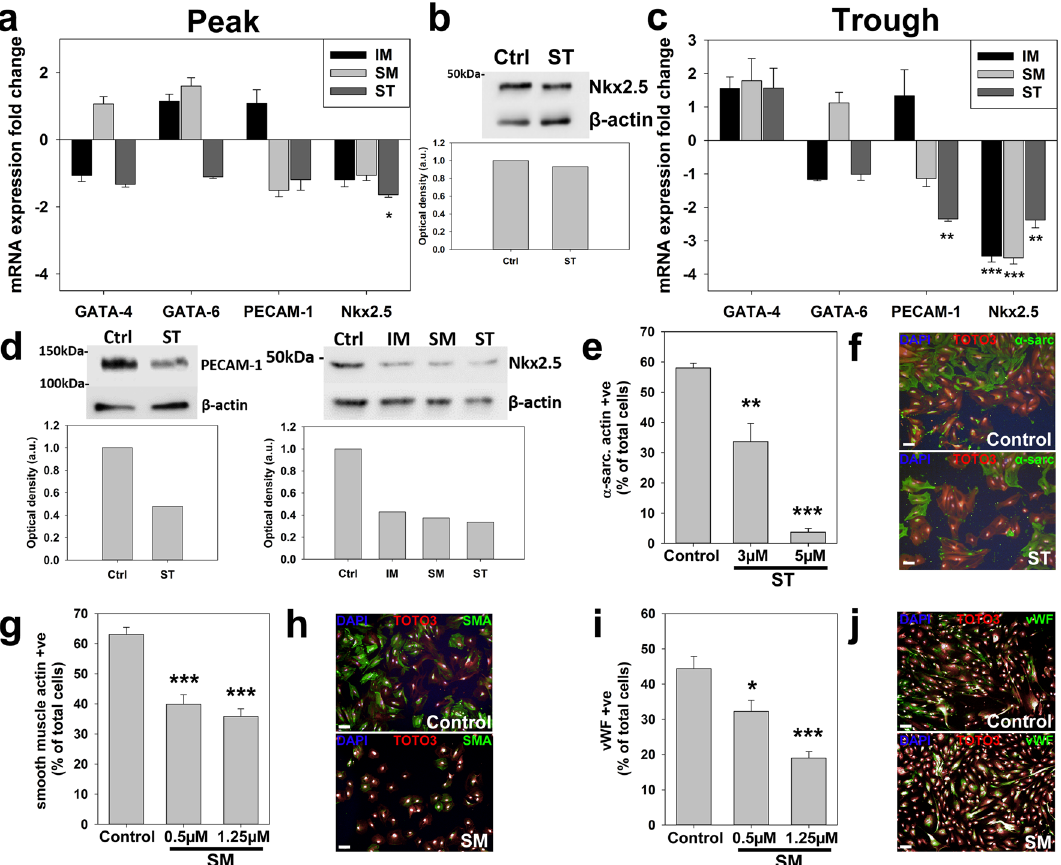
Figure 3. RTKIs reduce CPC potential to differentiate. ( a ) Real-time qPCR analysis of CPC early differentiation markers: Nkx2.5 reduced by 10 µM ST for 24 h and ( b ) but without changes to Nkx2.5 protein expression in CPCs post ST treatment. ( c ) Real-time qPCR analysis of CPC early differentiation: PECAM-1 reduced by 5 µM ST and Nkx2.5 reduced by 5 µM IM, 0.5 µM SM or 5 µM ST at 7 days; ( d ) protein expression was also assessed. Directed differentiation of CPCs in vitro determined that: ( e ) percentage of CPCs expressing α-sarcomeric actin was reduced by ST (n = 4), ( f ) representative images (scale bar = 100 µm); ( g ) percentage of CPCs expressing smooth muscle actin was reduced by SM (n = 4), ( h ) representative images (scale bar = 100 µm); ( i ) percentage of CPCs expressing von Willebrand factor was reduced by SM (n = 4), ( j ) representative images (scale bar = 100 µm). All data are mean ± SEM; significance was determined by ANOVA with Holm-Šídák post hoc test to identify differences (* p < 0.05; ** p < 0.01; *** p < 0.001). Blots cropped to relevant data, with optical density normalized to the loading control protein; full blot images presented in Supplementary Fig.